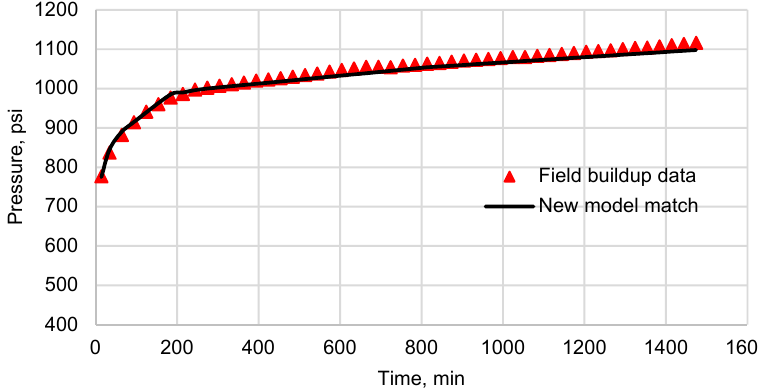
Figure 9. Field build up test is matched with mathematical model.